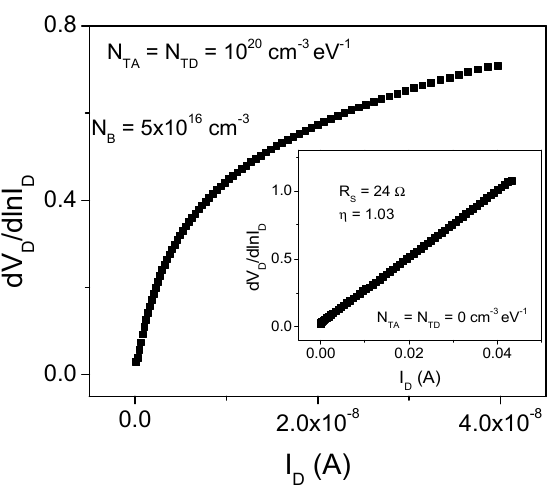
Figure 9. Plot of the dV D / dln ( I D ) vs I D , used for η and R S extraction in the Cheung extraction method.